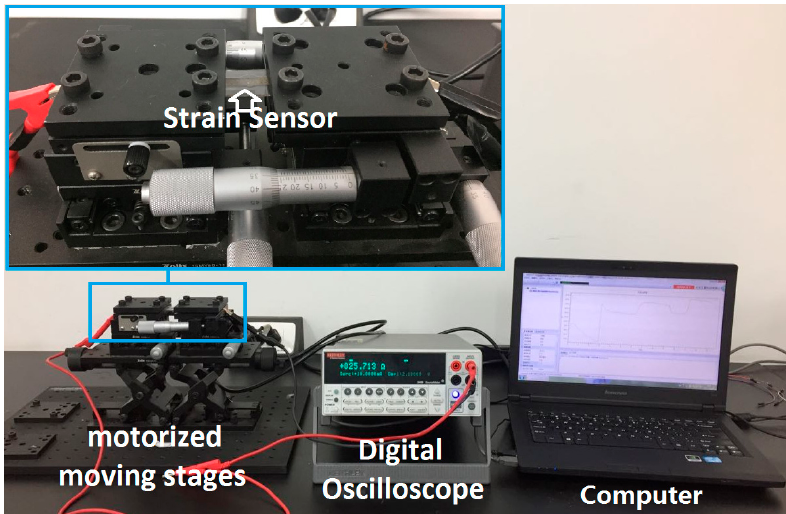
Figure 2. The strain sensing measurement platform.